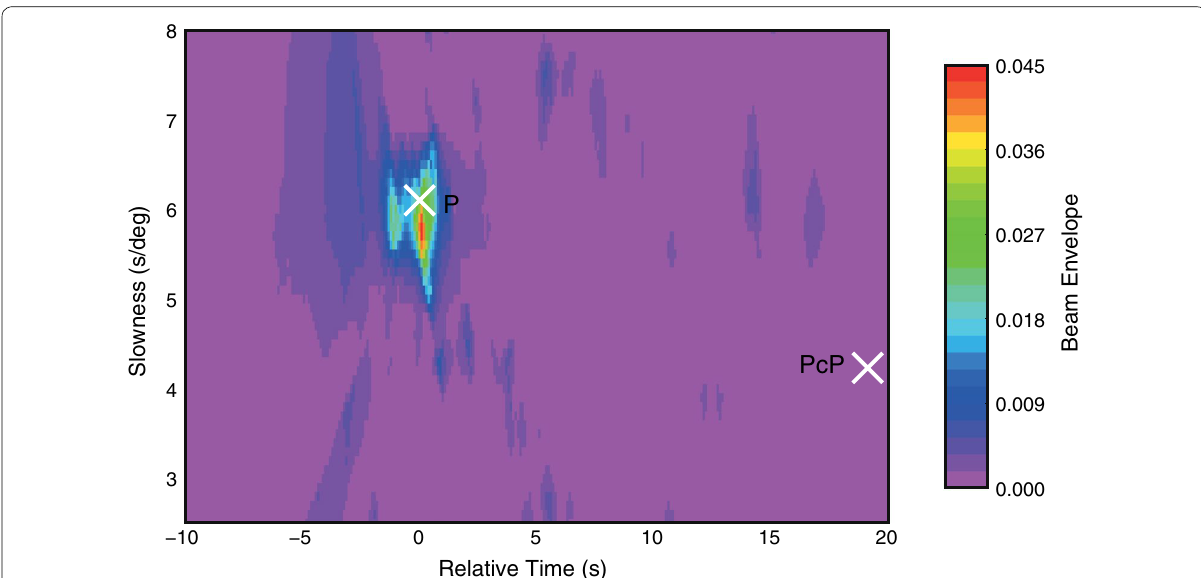
Fig. 4 Vespagrams of the original waveforms for Event 2010.02.15.21.51. A 3rd-root stacking is applied to the waveforms. The two white crosses denote the theoretical slowness values of P and PcP predicted by the AK135 model, respectively. Note that behind the strong direct P-wave energy, no other clear coherent arrivals are found within the analyzed time window (up to 25 s following the P arrival)